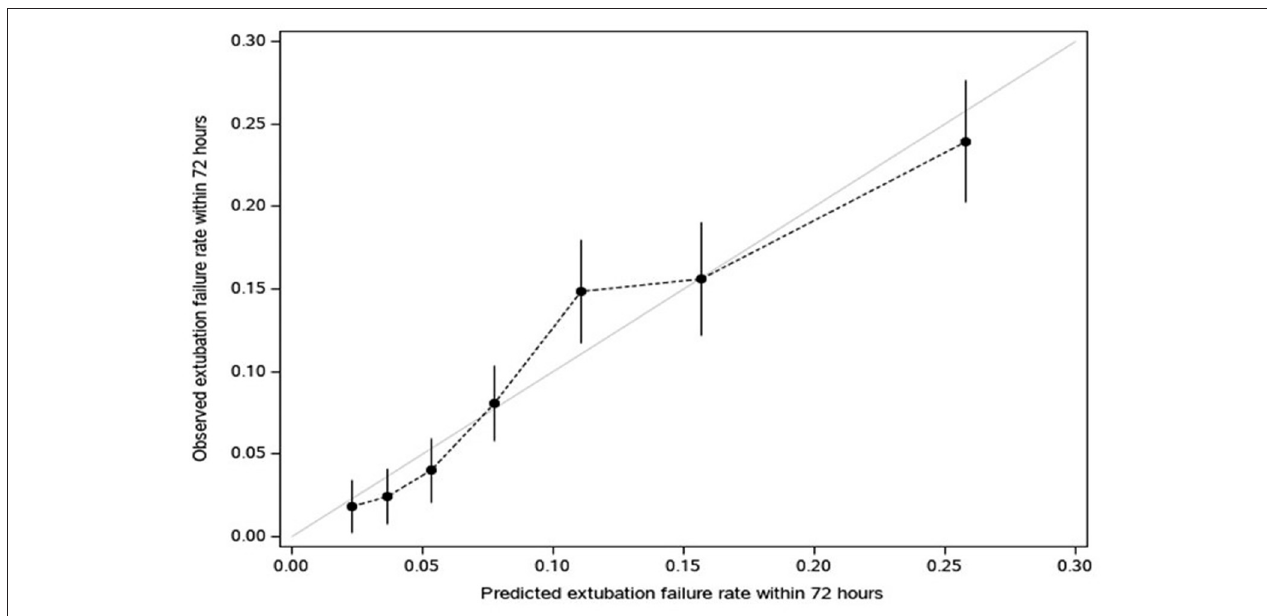
FIGURE 3 | Calibration plot of observed vs. predicted extubation failure in the validation set (dots convey the apparent calibration from the original model, in which predictions for extubation failure within 72h are grouped into deciles (10 groups ranging from low to high likelihood) and each related to observed rates (vertical bars reflect 95% CI for the rate); For a reference of perfect calibration, the Y = X line is displayed).